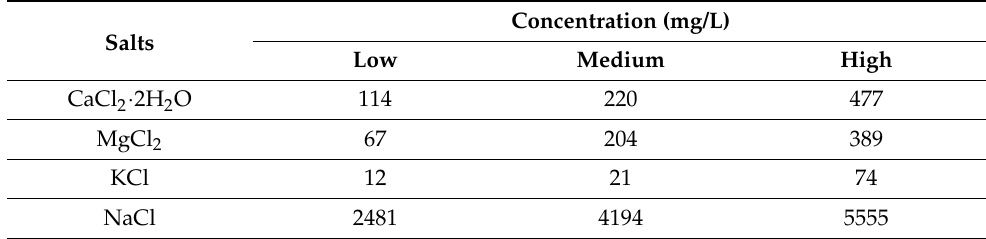
Table 2. Composition of synthetic process